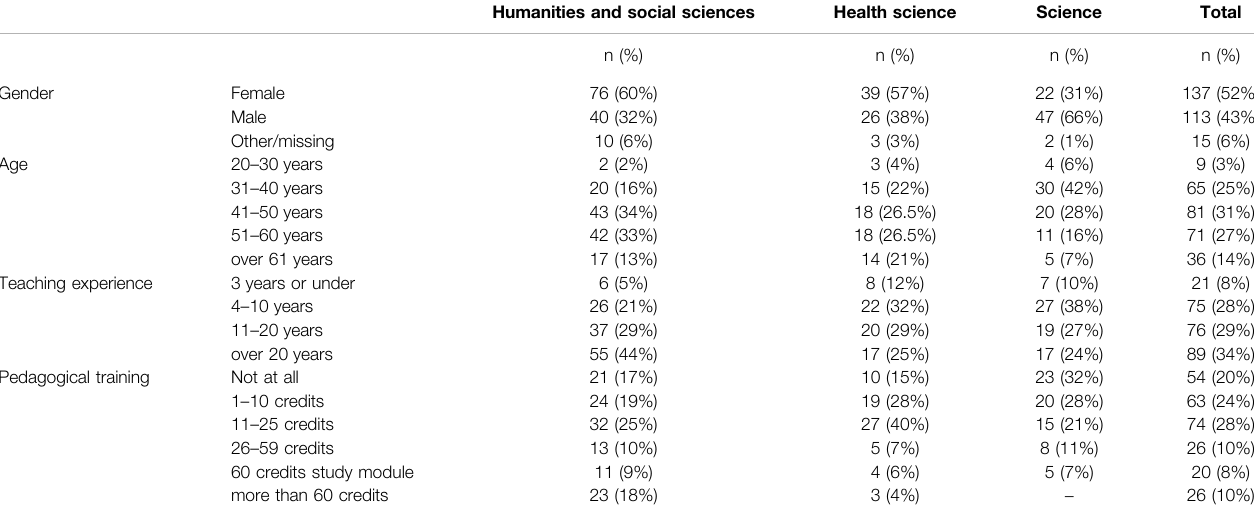
TABLE 1 | Descriptive information on demographic variables according to the academic fi